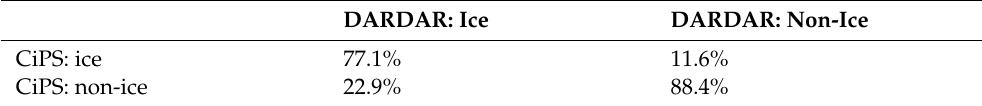
Table 1. Percentages of pixels classified as ice or non-ice by CiPS with respect to the SEVIRI-like